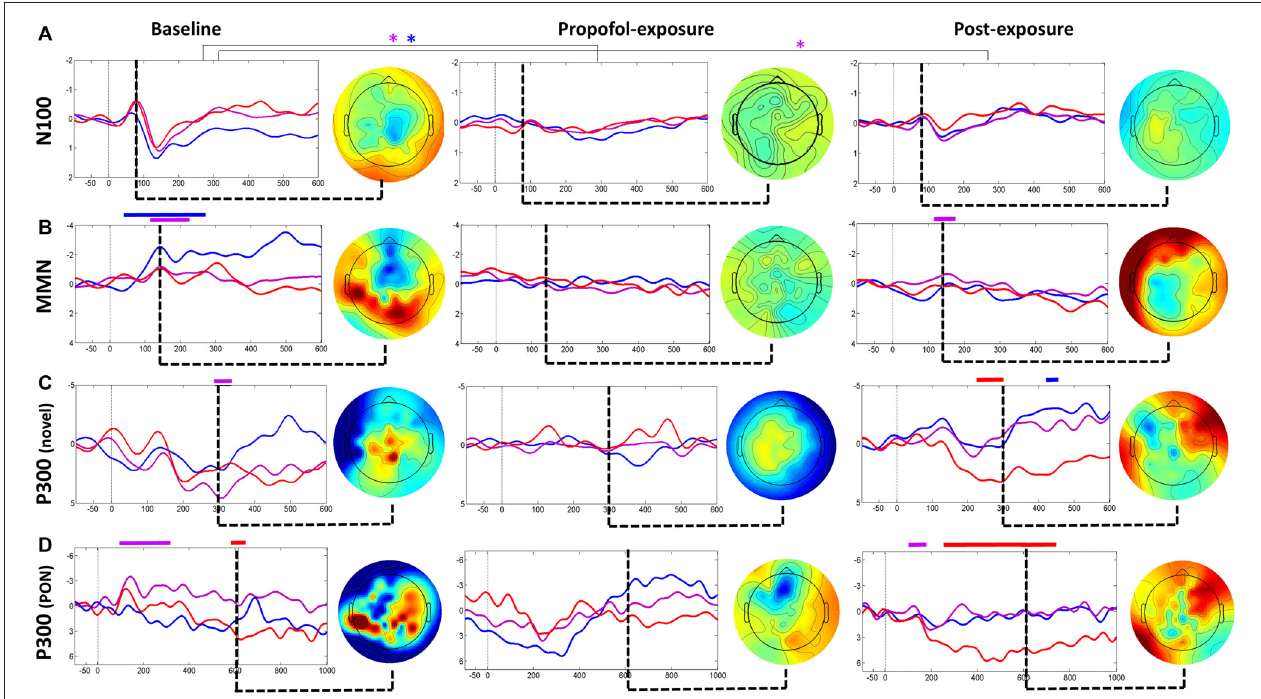
FIGURE 2 | Event-related potential (ERP) analysis for baseline, propofol exposure and post-exposure periods. Waveforms (A) and subtraction waves (B–D) are presented for electrodes Fz (blue), Cz (purple) and C4 (red). Time periods where significant differences occurred are indicated by a color-matched bar above the waveform plot. Blue ∗ , significant differences in Fz waveforms; Purple ∗ , significant differences in Cz waveforms.